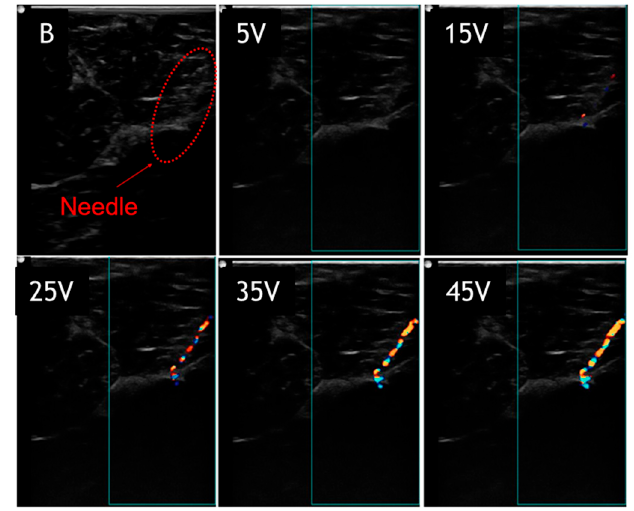
Figure 5. Visualized vibrating needle in porcine tissue at an angle of 60 ◦ and a depth of 2.5 cm with voltages (5, 15, 25, 35, 45 V).